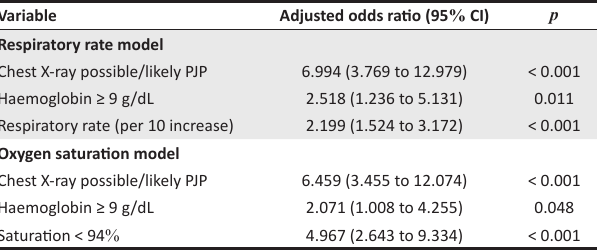
TABLE 3: The final multivariable logistic regression models used to create the clinical prediction rules.